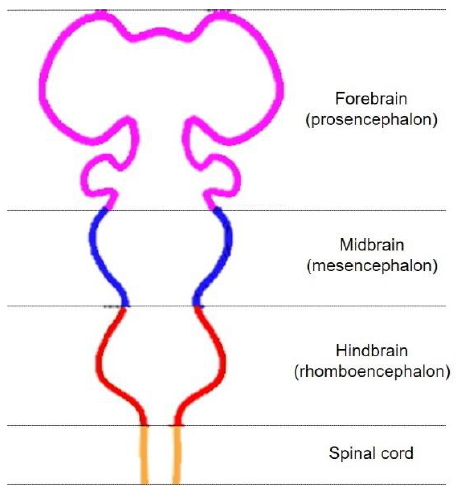
Figure 1. Schematic representation of developing neural tube.